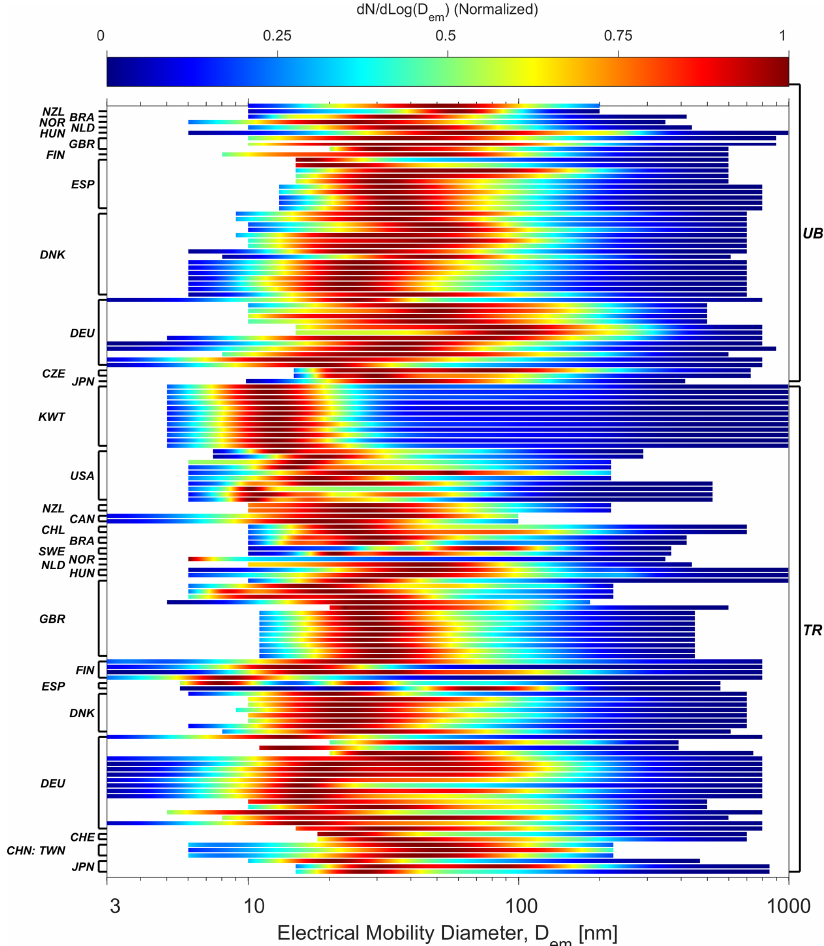
Figure 11. Comparison between normalized urban aerosol number PSDs measured at urban background (UB) and traffic-influenced (TR) sites. Only the number PSDs with a measurement period greater than 1 week are presented. The country codes are listed on the left, and the site type is listed on the